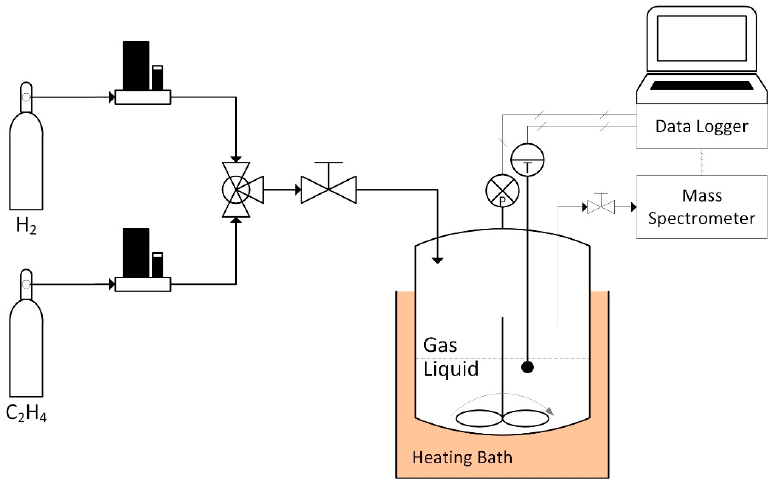
Figure 1. Scheme of the batch reactor and the related control scheme.